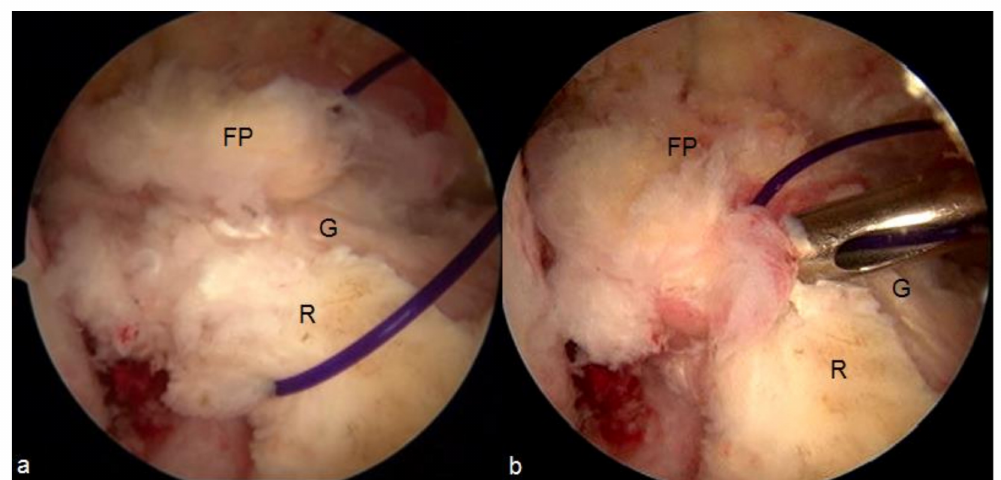
Figure 5. The PCL fat pad technique combined with the distal anterior cruciate ligament (ACL) remnant preservation: ( a ) The fat pad (FP) and the distal remnant of a native ACL (R) adjacent to the ACL graft (G); ( b ) Entire ACL graft covered with the fat pad and the distal remnant of a native